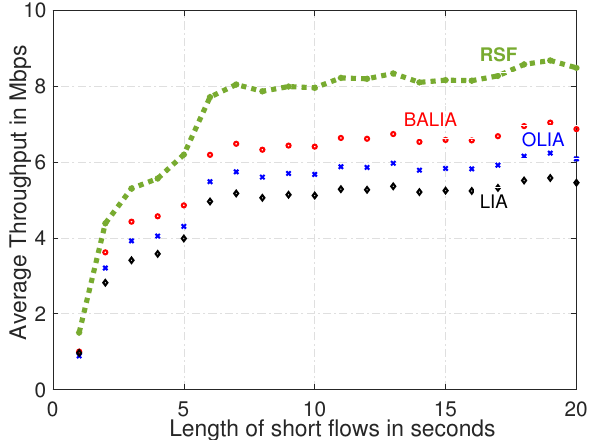
Figure 8. Throughput results for Scenario 7: short-lived flows. Both paths had 20 Mbps bandwidth, 150 ms delay, and 2% packet loss probability. Short-lived flows arrived and departed at random times according to Poisson